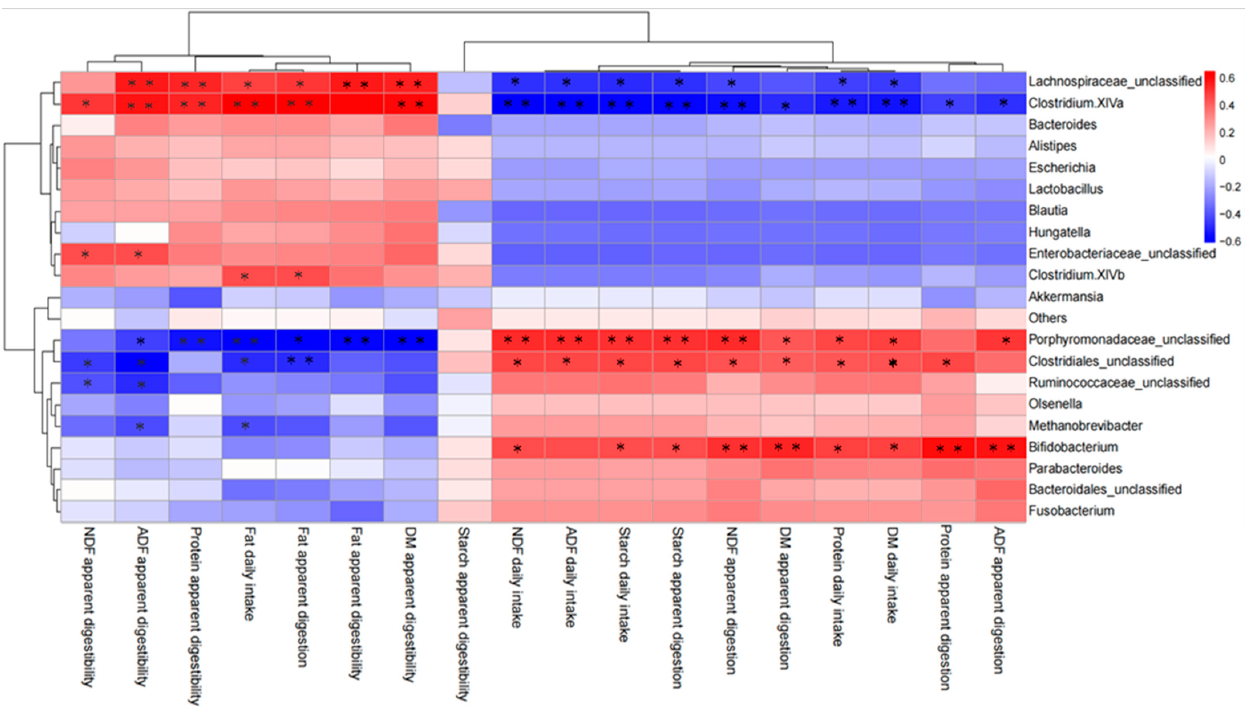
Figure 5. Correlation between the top 20 genus-level taxonomic composition and apparent digestibility. Data marked with * indicates a significant correlation ( p < 0.05), and data marked with ** indicates an extremely significant difference ( p < 0.01). Table 6. Nutrient contents of feces at different sample times.